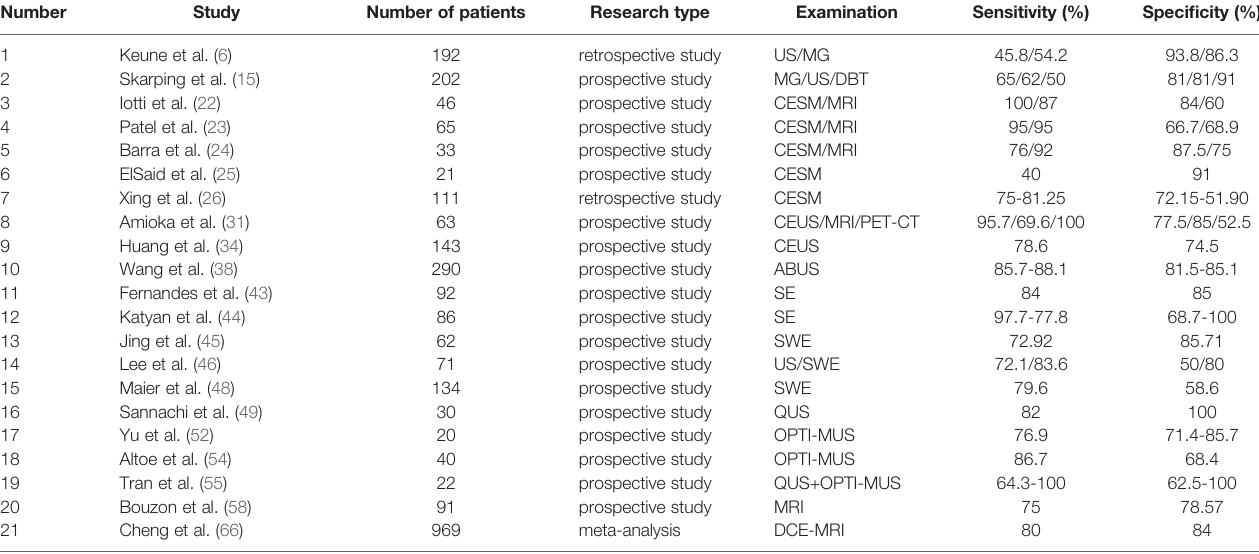
TABLE 1A | Studies on the ef fi cacy of various imaging techniques for breast cancer NAC (References to this article) (A) Studies on the ef fi cacy of various imaging techniques on breast cancer NAC (evaluation index: Sensitivity, Speci fi city).